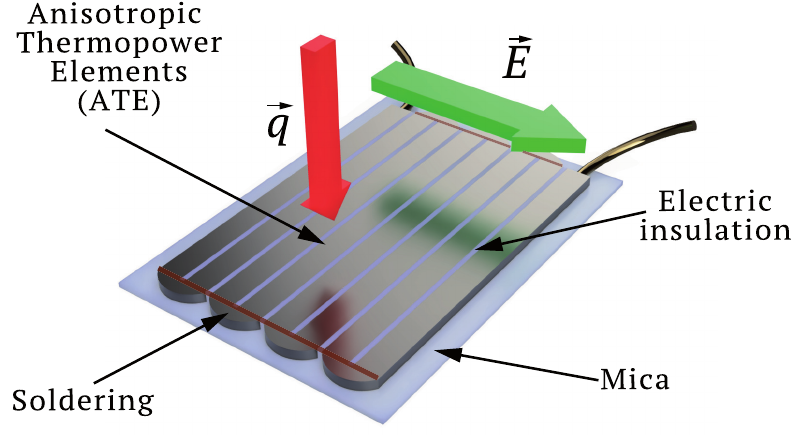
Figure 3. Scheme of GHFS.